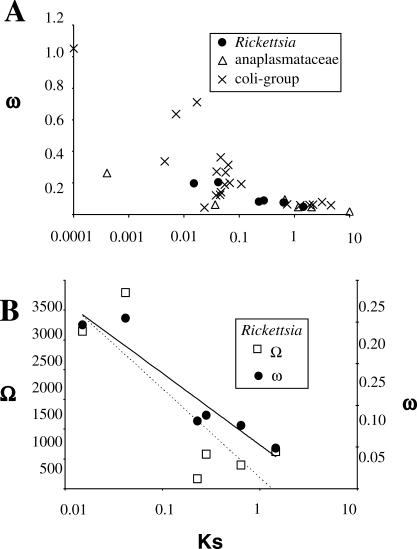
Associations between ω or Ω and Ks(A) The ratio ω = Ks/Ka and Ks were estimated between all possible pairs of genomes within a bacterial group using the concatenated alignment of 198 conserved orthologous genes. Values estimated from phylogenetically redundant pairs (e.g., R. felis and R. conorii; R. felis and R. africae) were averaged.(B) The Ω ratios (number of gene loss to Ks) were calculated between all possible pairs of Rickettsia genomes and close values were averaged. The number of gene loss between any two genomes was taken as the sum of the loss events inferred along the branches separating the two species (Figure 1). A logarithmic regression of Ω is represented by a dashed line. The corresponding ω ratios (same as Figure 5A) and the associated logarithmic regression (black line) are given for comparison.